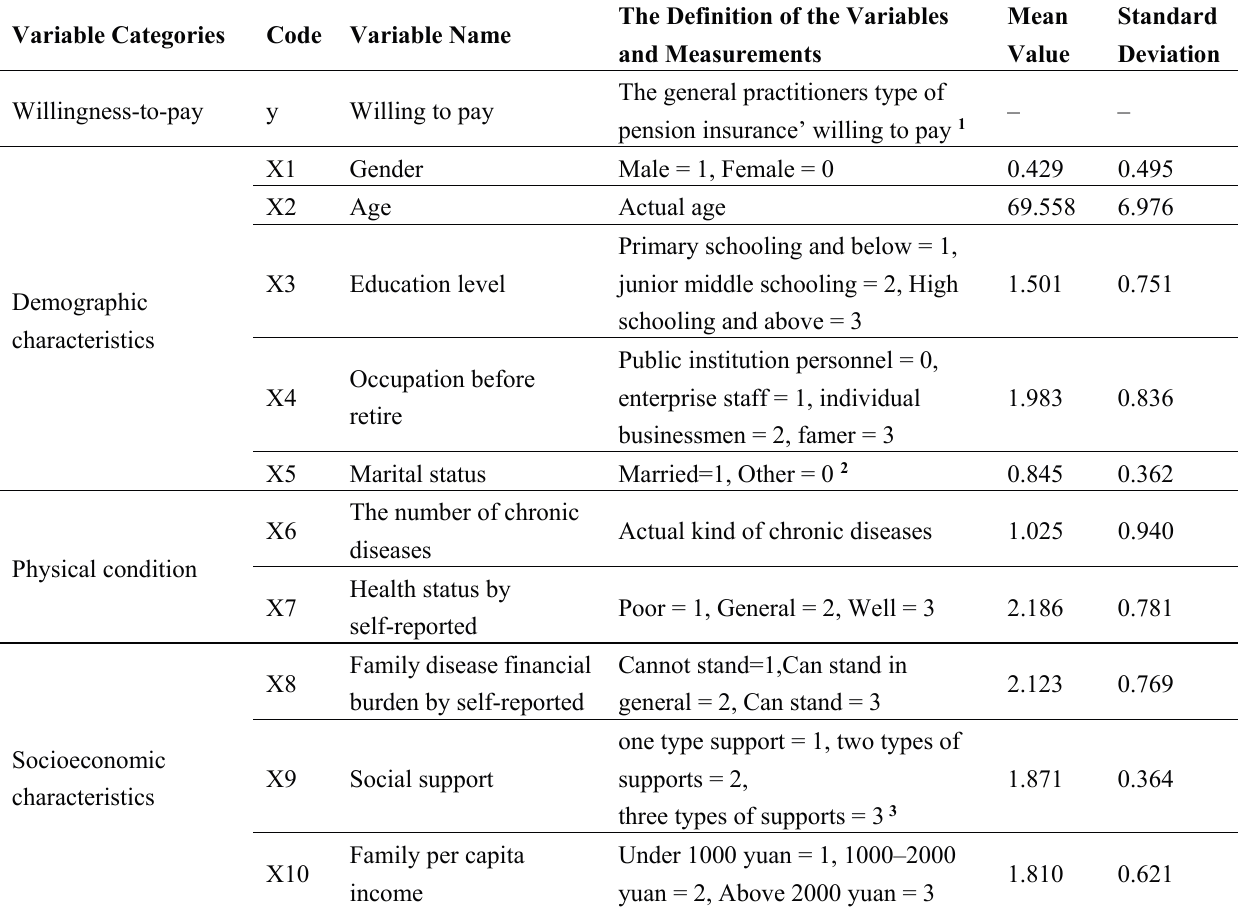
Table 4. Variable definition and statistical